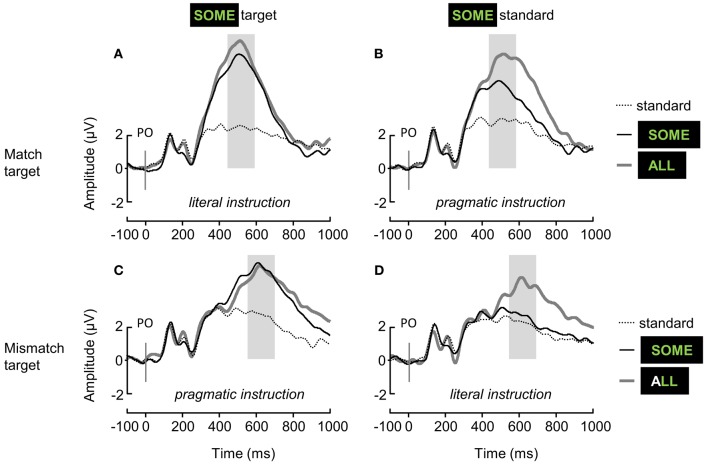
Grand-average ERP waveforms elicited over the Parieto-Occipital region (linear derivation of Pz, PO3, PO4, POz) by standard items (dotted gray lines), unambiguous target-ALL (solid gray lines), and ambiguous-SOME (solid black lines), depending on the Block type (A,B, match target; C,D, mismatch target), and the status of ambiguous-SOME (A,C, target; B,D, standard). In italics: the context of interpretation of ambiguous-SOME. The shaded areas represent the time-windows used for the analysis of P3b mean amplitudes.